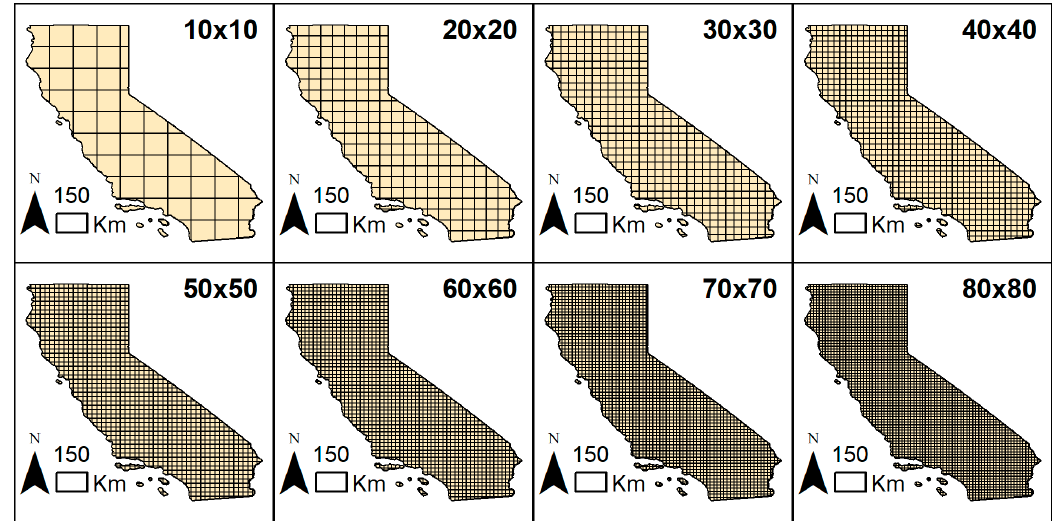
Figure 3. Spatial mesh in various resolutions generated for the state of California.